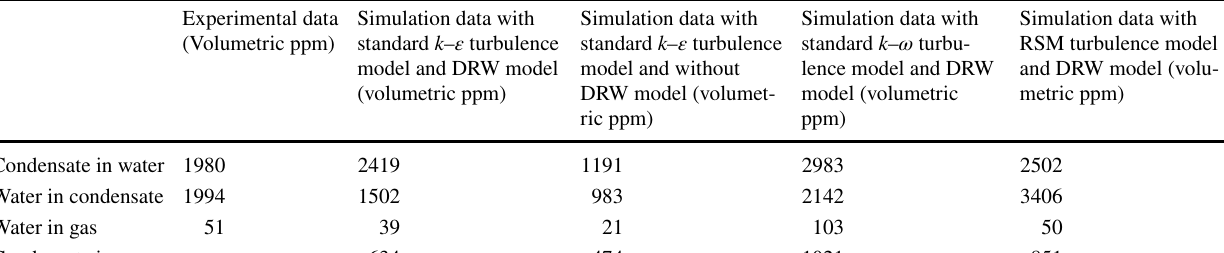
Table 6 Comparison of field and simulation data for Case 7